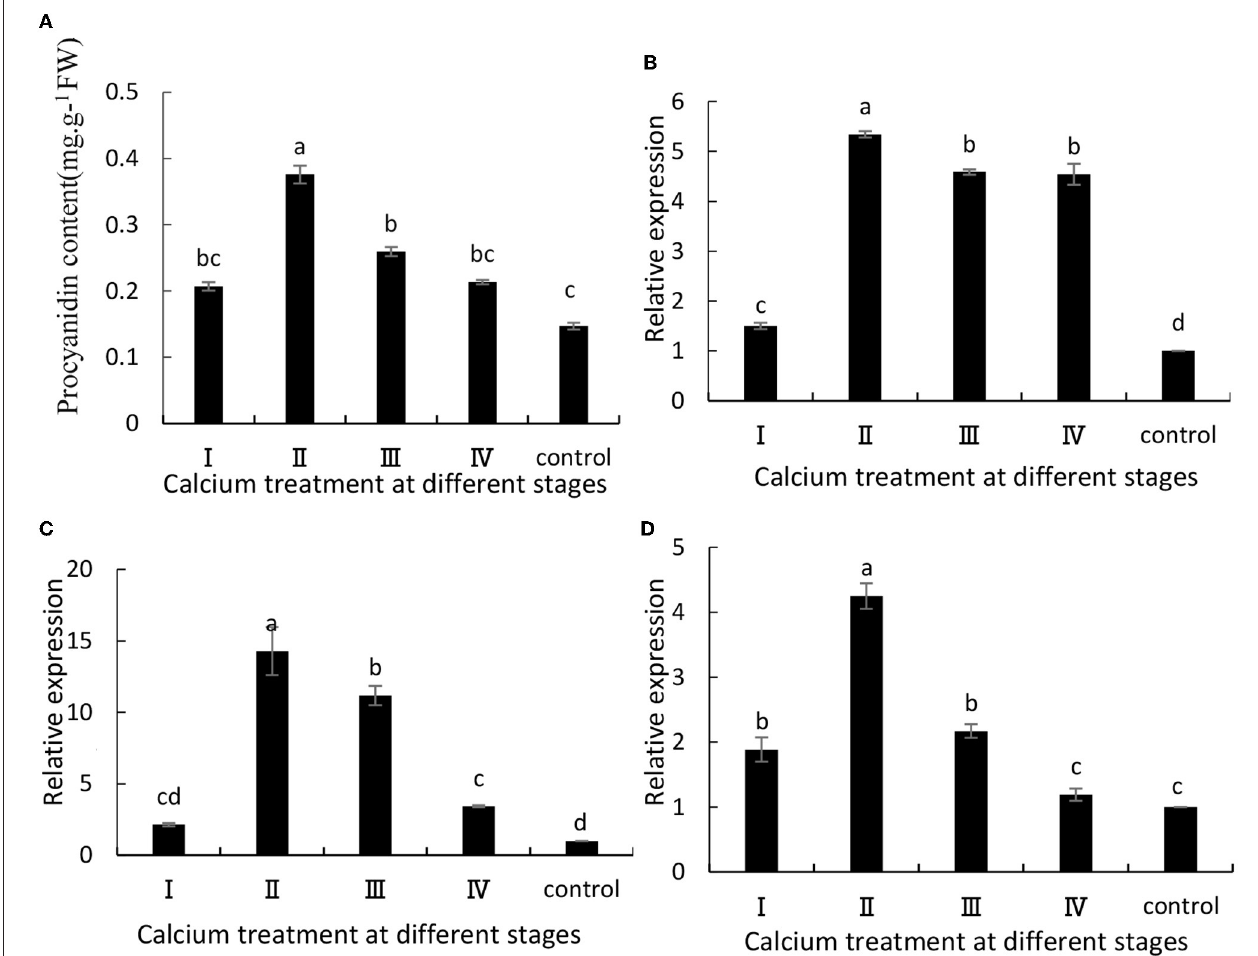
FIGURE 4 | (A) Anthocyanin content and expression of (B) VvUFGT, (C) VvmybA1, and (D) VvDFR. Data are presented as mean ± standard. Lowercase letters represent significant differences ( P <